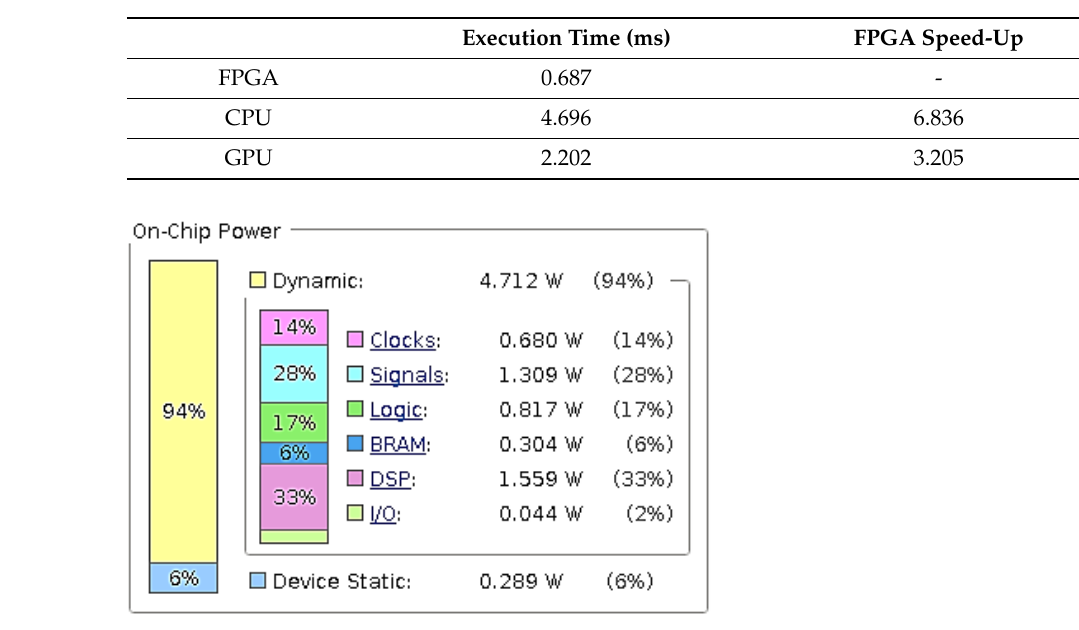
Table 2. Performance comparison to CPU and GPU.